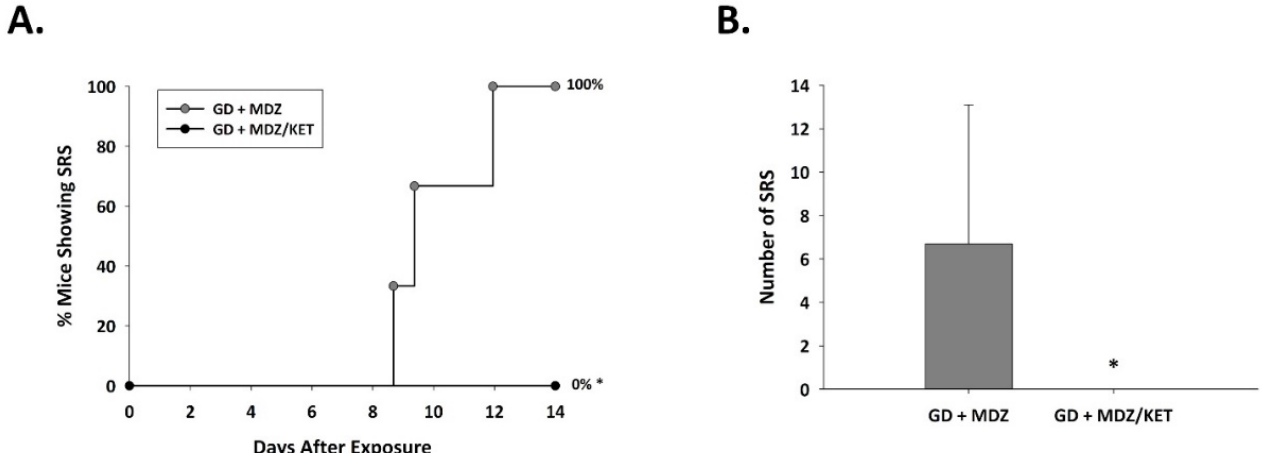
Figure 7. Effect of ketamine as an adjunct to delayed midazolam treatment on the development of spontaneous recurrent seizures in soman-exposed KIKO mice. KIKO mice were SC exposed to soman and treated at 15 min after seizure onset with midazolam monotherapy (GD + MDZ) or midazolam/ketamine combination therapy (GD + MDZ/KET), and EEG activity was monitored for 14 days after exposure. ( A ) The onset of the first detected SRS for each surviving animal is graphed to indicate the percentage of mice in each group that developed SRS. All 3 GD + MDZ mice that survived 14 days after GD-induced seizure developed SRS, whereas 9 survivors of the GD + MDZ/KET group did not develop SRS. ( B ) The average ( ± SD) number of SRS events is graphed for each group. * p < 0.05.2.2.3. Ketamine in Combination with Midazolam at 15 Min after Seizure Onset Offers Neuroprotection and Reduced Neuroinflammatory Response in GD-Exposed KIKO Mice.